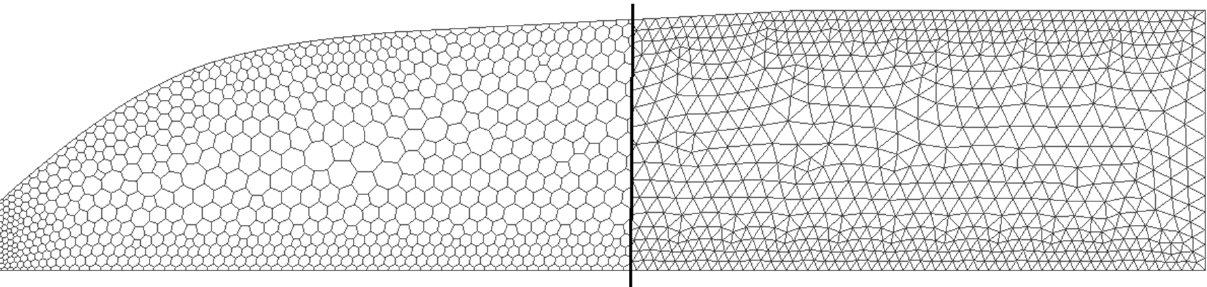
Figure 4. Computational grid before and after the process of conversion from tetrahedral mesh to polyhedral mesh.